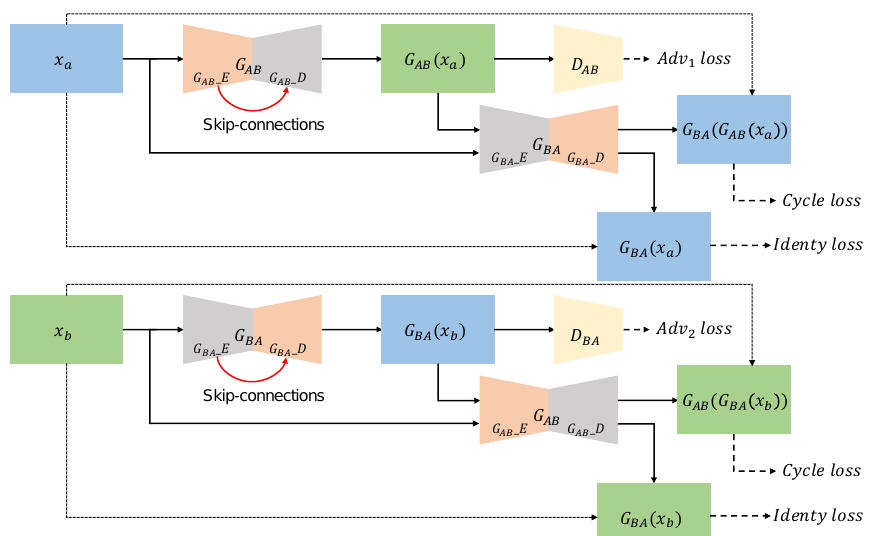
Figure 2. Overview of the proposed method. The blue boxes represent sunny data, and the green boxes represent adverse weather data. G AB is the generator from sunny to adverse weather, and G BA is the generator from adverse weather to sunny. D AB and D BA are the discriminators for each domain. The red arrows below G AB and G BA represent skip connections. The proposed method adopts ResNet-based generators and includes skip connections to improve the